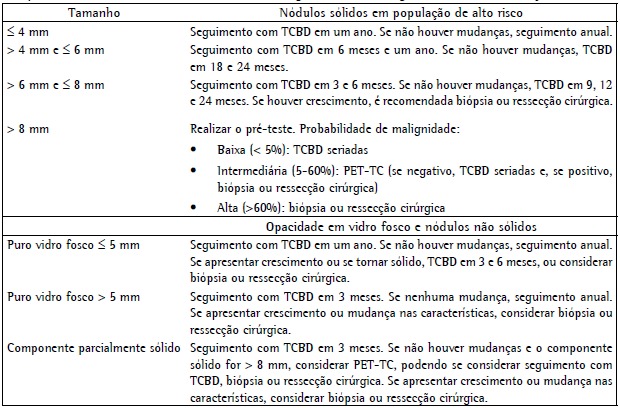
Descrição das opções de acompanhamento dos pacientes de alto risco em
relação à presença de nódulos sólidos, opacidade em vidro fosco e nódulos
não sólidos, com base nas recomendações do National Comprehensive Cancer
Network Guidelines for Lung Cancer Screening e da Fleischner Society.a TCBD:
TC de baixa dosagem; e PET-TC: positron emission tomography-TC (TC por
emissão de pósitrons combinada com TC). aAdaptado de National Comprehensive
Cancer Network,(7) MacMahon et al.(8) e Patel et al.(9)